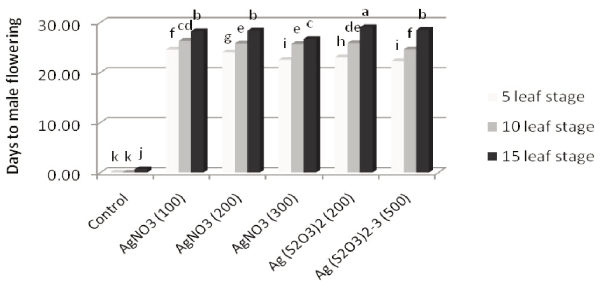
Table 5 - The mean comparison for some of the studied traits in different leaf growth stages in cucumber Developmental stages DMF NNMF IL NMF Five leaf stage (LS1) Fifteen leaf stage vesting; FWH= fruit weight per harvesting (g). Means followed by the same letter in each column were not significantly different at 0.05 level using LSD test.